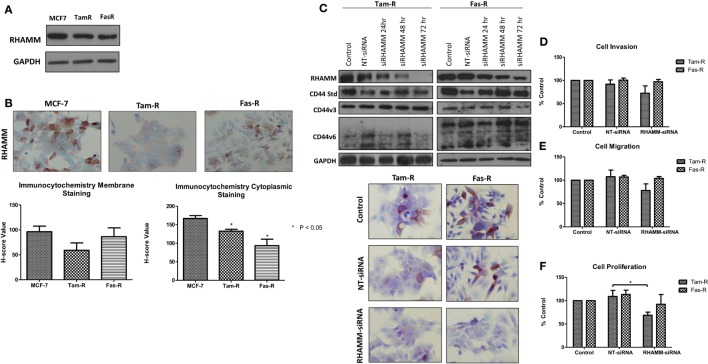
Inhibition of RHAMM expression does not alter the aggressive behavior of endocrine-resistant breast cancer cells. (A) Western blotting revealed a similar level of RHAMM protein expression across MCF-7, Tam-R, and Fas-R cells, which was confirmed by immunocytochemistry and H-score analysis. (B). Suppression of RHAMM by siRNA (C), confirmed with immunocytochemical staining and Western blotting, did not alter CD44 variant isoform expression. RHAMM suppression did not alter the invasive (D) or migratory (E) capacity of Tam-R and Fas-R cells although some suppression of Tam-R proliferation was observed in the absence of RHAMM (F).